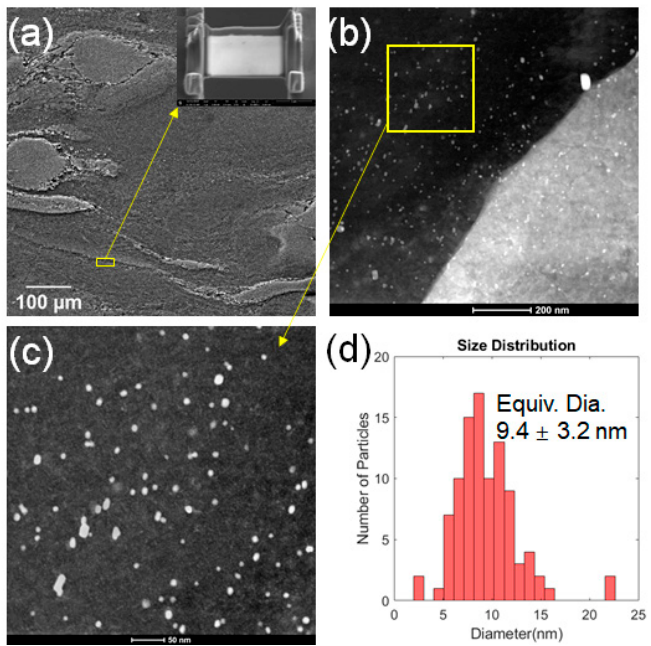
Figure 14. ( a ) SEM image of the selected area for FIB life-out membrane from the sample deformed to ε t of − 0.40 at (cid:2013)(cid:4662) of 10 s − 1 , ( b ) HAADF image in STEM mode for the sample lifted out in ( a ), ( c ) nano-sized Zn–Zr particles, and ( d ) size distribution histogram quantified from the micrograph in ( c ) showing the mean equivalent diameter of these Zn–Zr particles was about 9.4